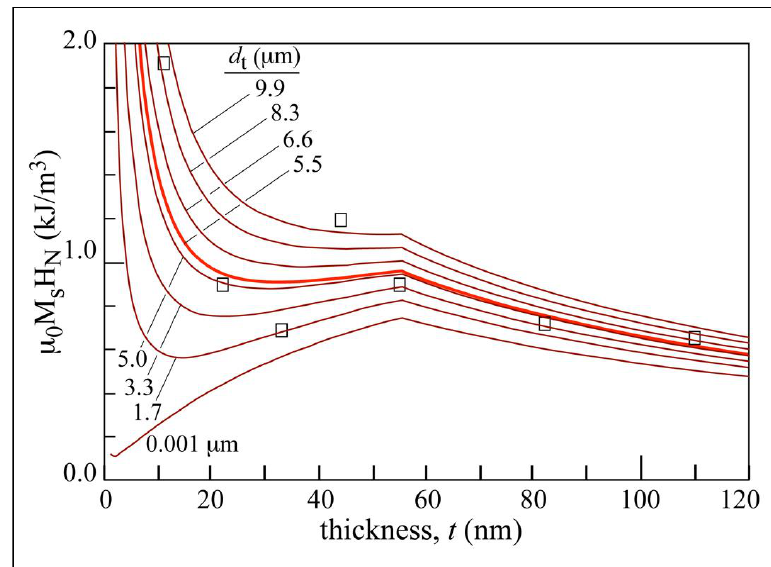
Figure 11. Set of calculated density energy curves (Equation (5)) for different values of tail wall width parameter d t . The case where the effect of surface roughness is almost null corresponds to the absence of this tail d t = 1 nm. Experimental values of the applied magnetic field to nucleate walls (square symbols) are represented as well as its best fit (bold red line) for d t = 5500 nm.